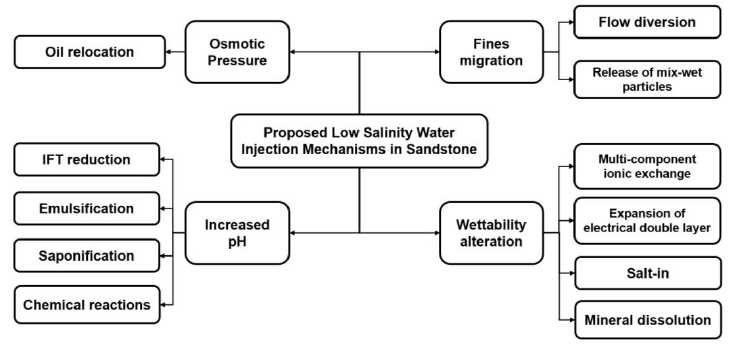
Figure 3. Overview of some proposed mechanisms of LSWI in sandstones.